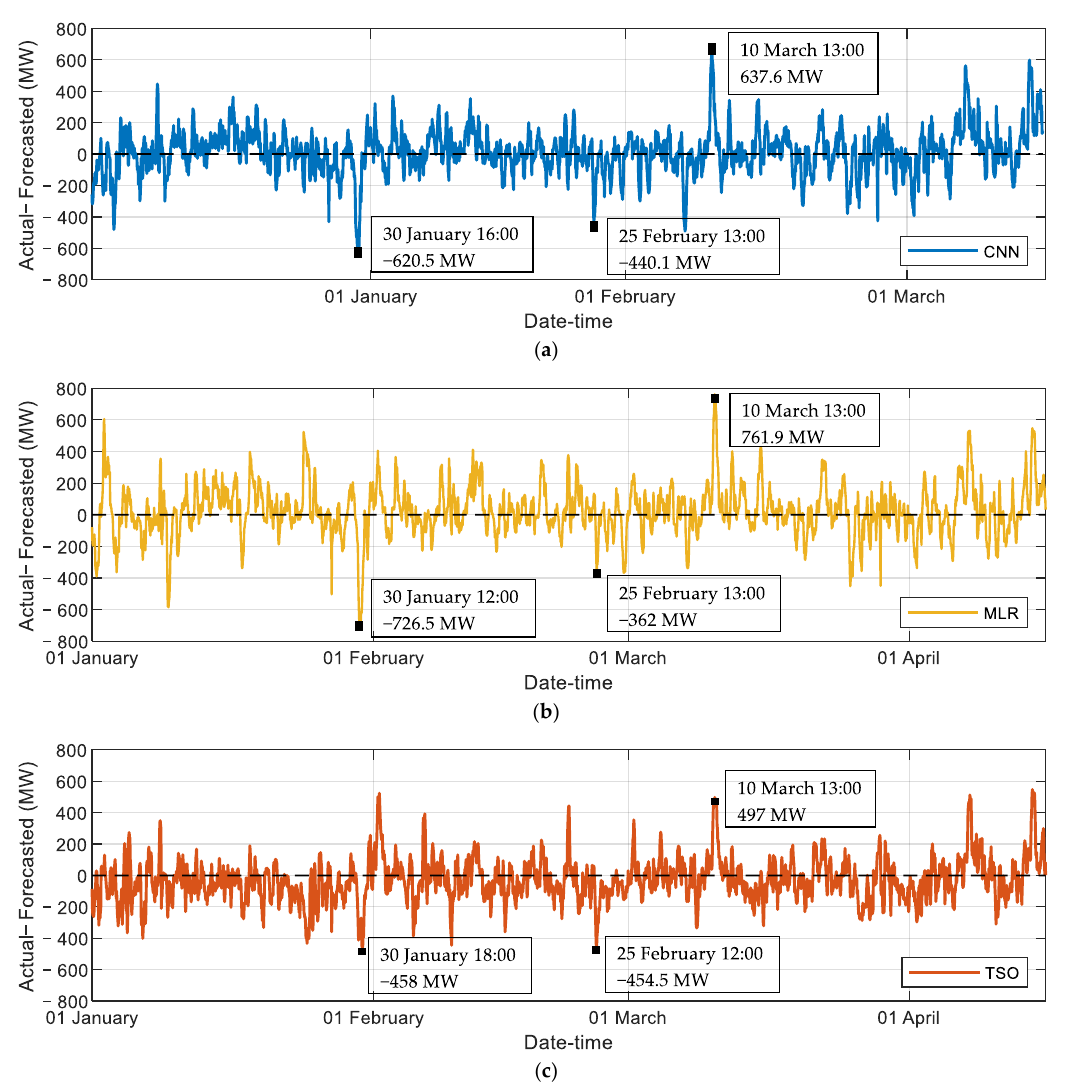
Figure 8. Absolute errors in the testing set achieved by ( a ) Convolutional Neural Network (CNN); ( b ) Multiple Linear Regression (MLR); ( c ) Transmission System Operator (TSO).